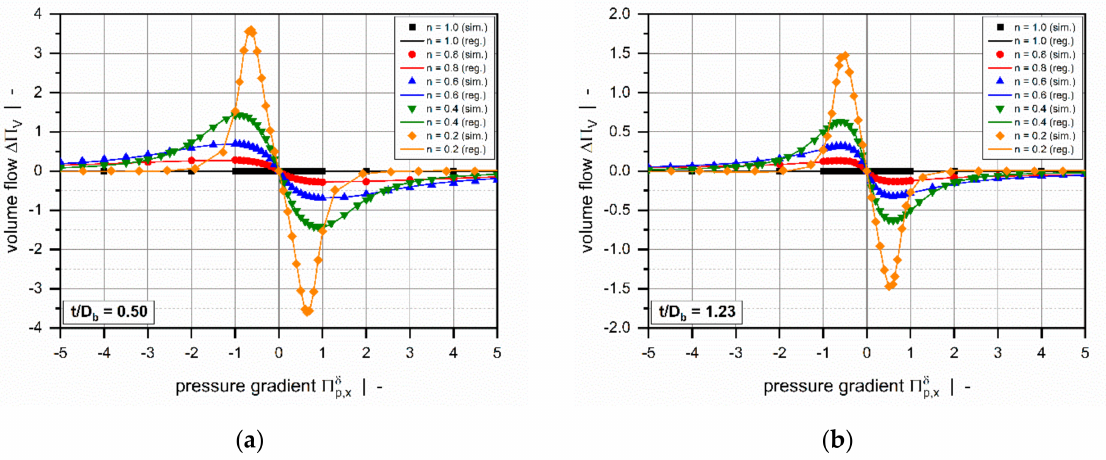
(cid:16) (cid:17) = f t / D b , n , Π δ p , x and numerical solutions V